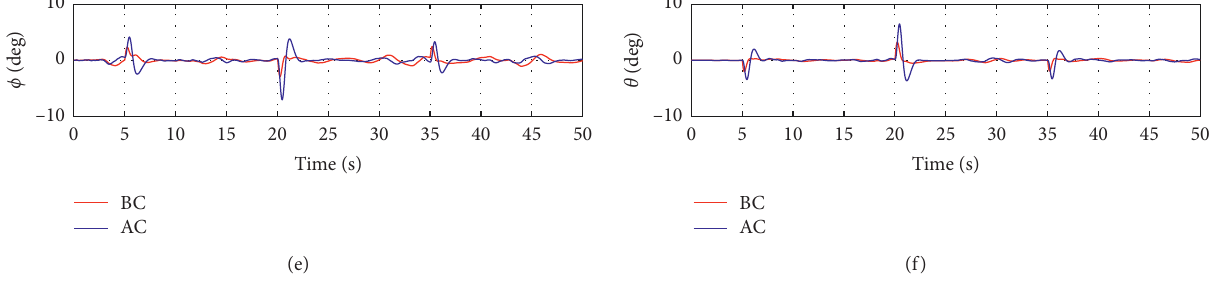
Figure 17: System responses in Scenario 2.